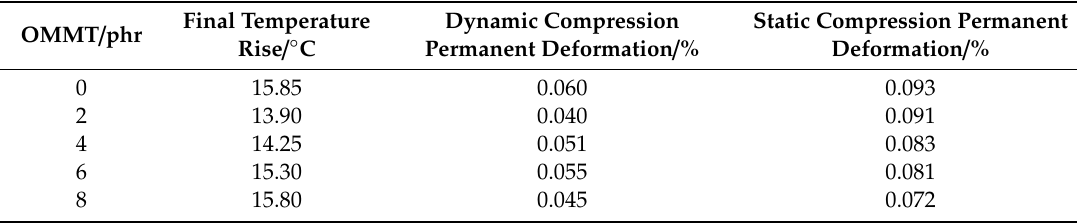
Table 3. The e ff ects of OMMT content on the compressed heat generation and compression permanent deformation of vulcanized rubber.